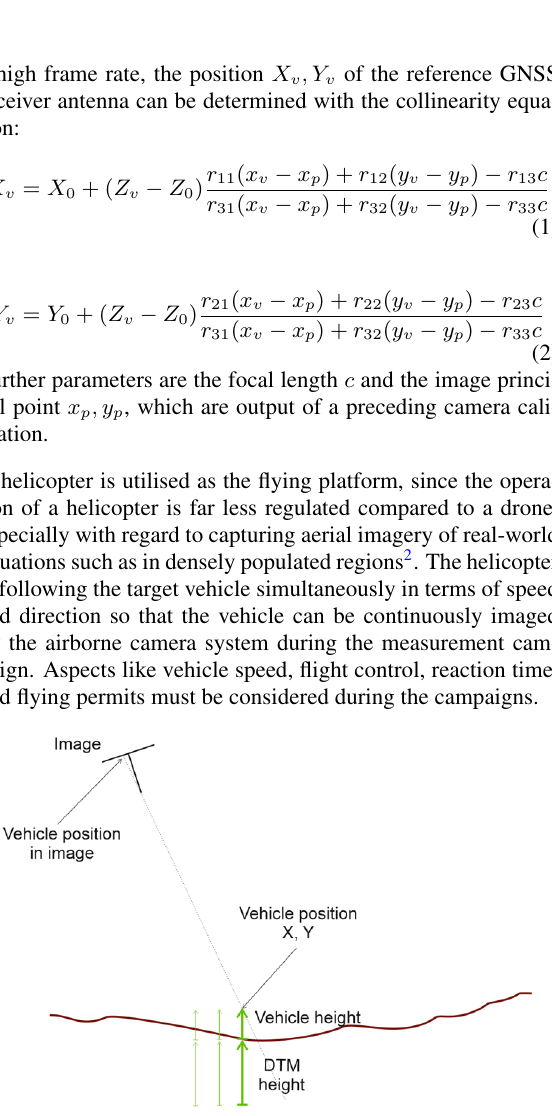
Figure 1. Principle of determining the position of the automotive GNSS device by using one aerial image and an independent height information.